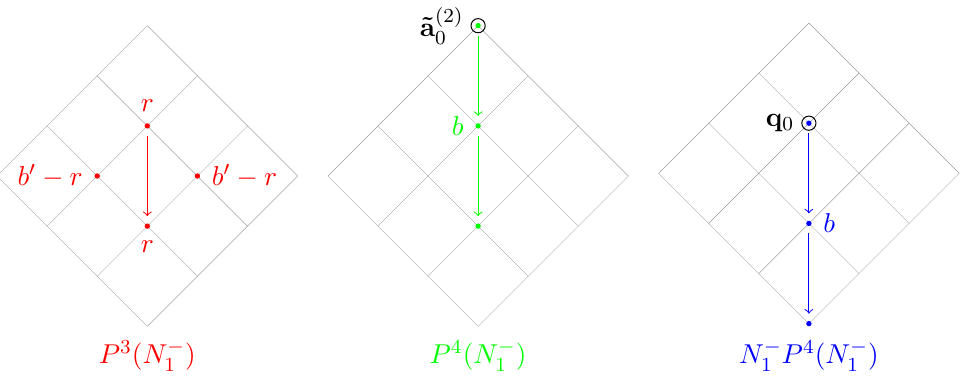
Figure 15 . The left picture shows a mixed Hodge structure on P 3 ( N (cid:0) mixed Hodge structure on P 4 ( N (cid:0) ), and the right picture shows the image of the middle picture 1 under the action of N (cid:0) . In these diamonds, the arrows label the action of N (cid:0) 1 in agreement with equation (4.44) and (cid:12)gure 14. The sum of these three Hodge-Deligne diamonds (cid:0) (cid:1) is the diamond of F ; W (2) of type IV d . Again, q 0 and ~a (2) (2)